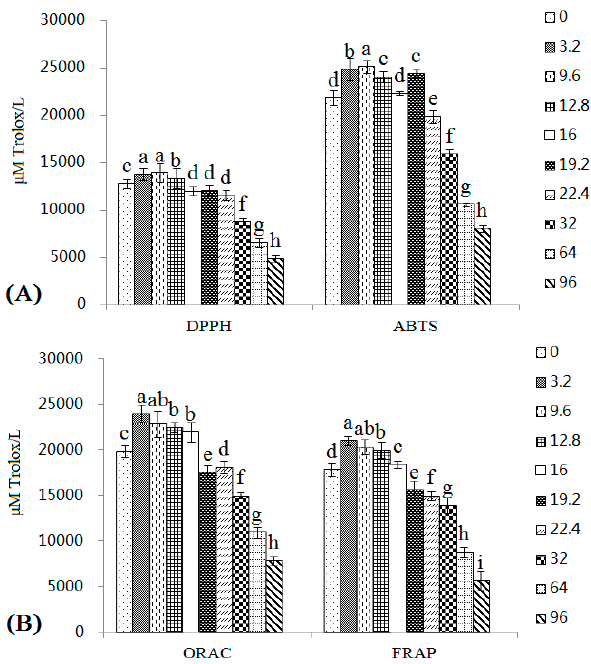
Figure 5. Changes in the antioxidant activities of wines with different copper concentrations were determined using the DPPH radical scavenging activity ( μ M Trolox/L), ABTS radical scavenging activity were determined using the DPPH radical scavenging activity ( µ M Trolox/L), ABTS radical ( μ M Trolox/L) ( A ), ORAC radical scavenging activity ( μ M Trolox/L) and FRAP radical scavenging scavenging activity ( µ M Trolox/L) ( A ), ORAC radical scavenging activity ( µ M Trolox/L) and activity ( μ M Trolox/L) methods ( B ). Different letters indicate statistically significant differences (Duncan’s FRAP radical scavenging activity ( µ M Trolox/L) methods ( B ). Different letters indicate statistically multiple range test, p < 0.05) between samples with different copper concentrations. significant differences (Duncan’s multiple range test, p < 0.05) between samples with different copper